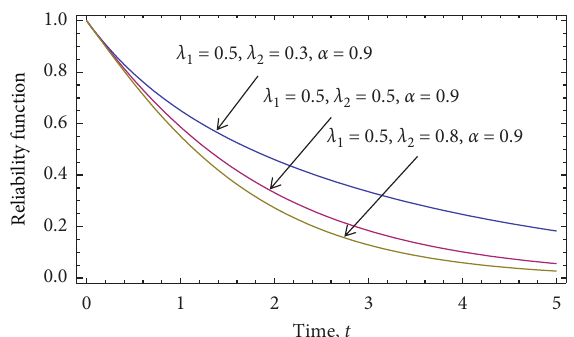
Figure 4: System reliability versus failure rate λ